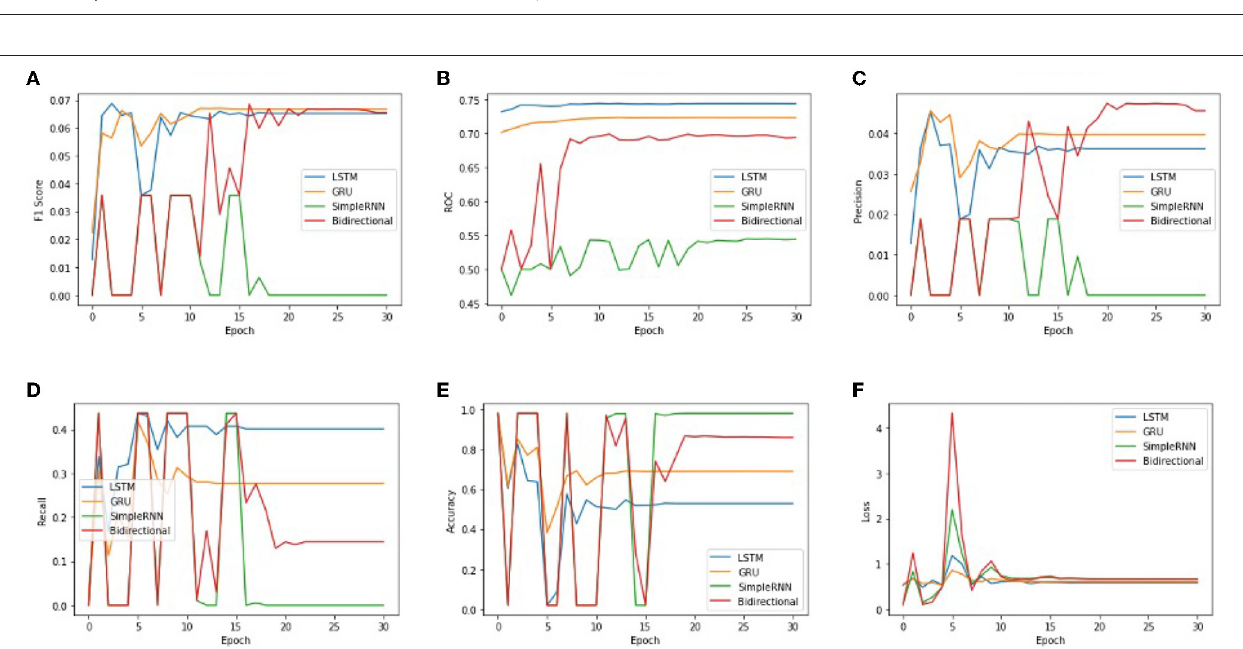
FIGURE 6 | The performance metrics of different architecture of RNN with the variable number of epochs (A) F1 score, (B) ROC, (C) Precision, (D) Recall, (E) Accuracy, and (F) Loss.